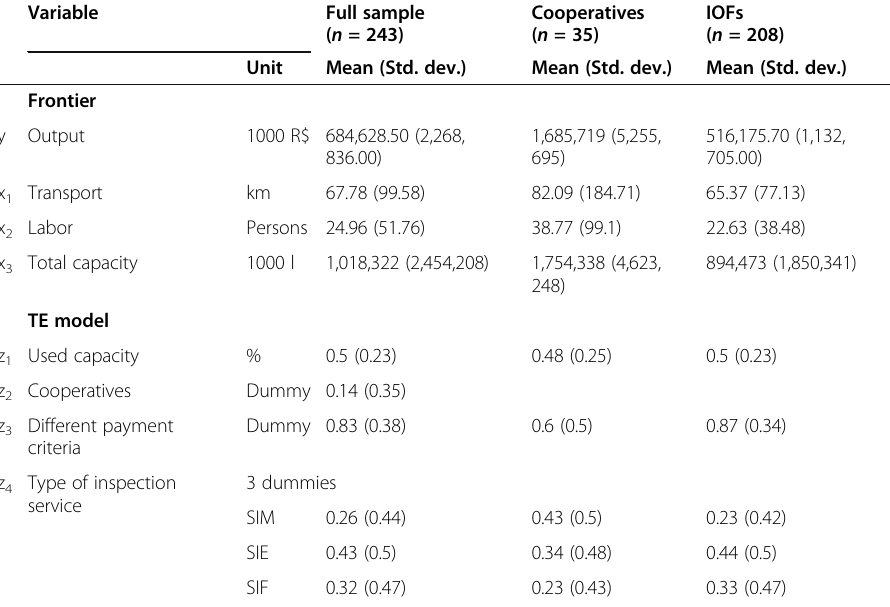
Table 2 Descriptive statistics of the output and inputs